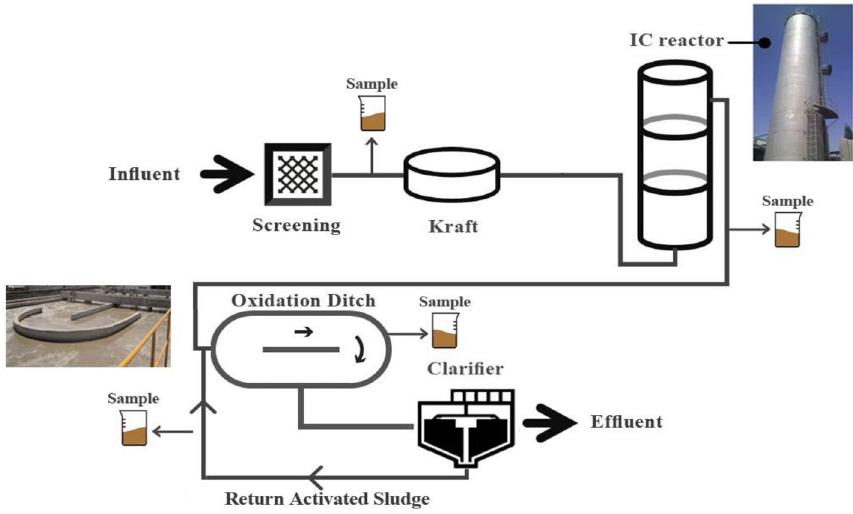
Figure 1. Schematic diagram of full-scale RPCM-WWTP. Note . RPCM: Recycled paper and cardboard mill; WWTP: Wastewater treatment plant.